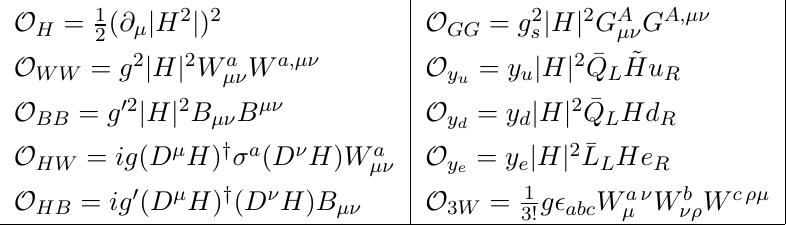
Table 1 . A complete set of CP-even dimension-six operators that contribute to the Higgs and TGC measurements, assuming there is no correction to the Z -pole and W mass measurements and no dipole interaction. We only consider the (cid:13)avor-conserving component of contributing to the top, charm, bottom, tau, and muon Yukawa